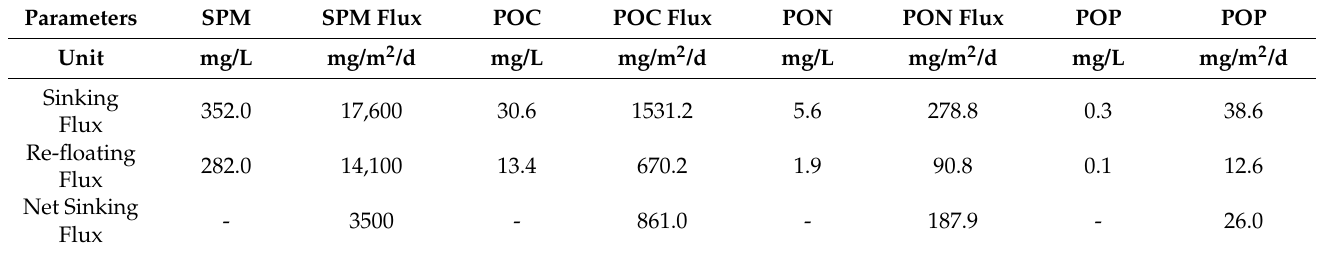
Table 1. Estimated sinking/re-floating suspended particulate matter (SPM), particulate organic carbon (POC), nitrogen (PON), and phosphorus (POP) fluxes at the bottom seawater–surface sediment